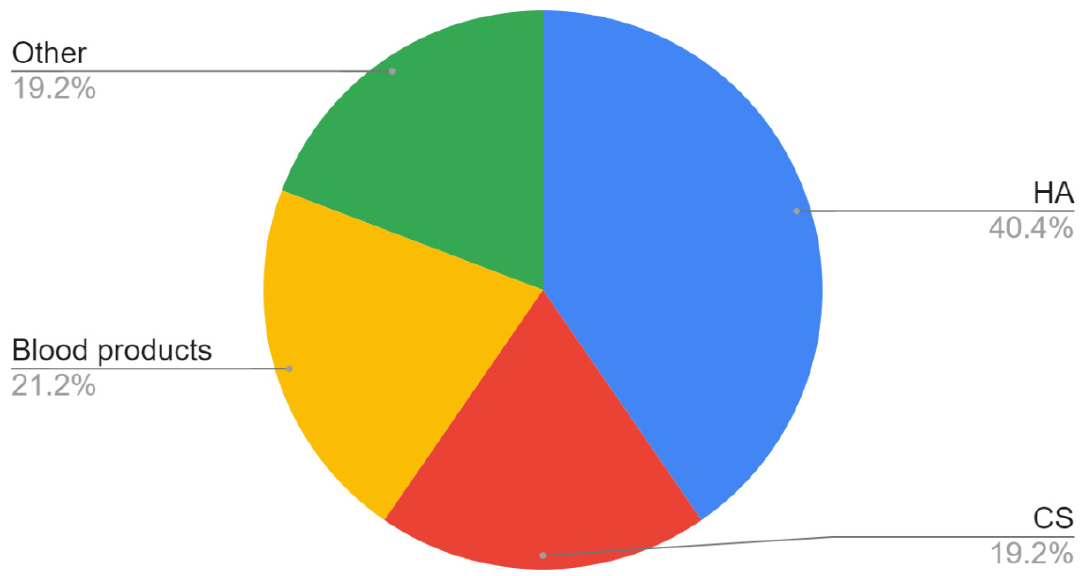
Figure 2. Use of individual substances: HA—hyaluronic acid; CS—corticosteroids.